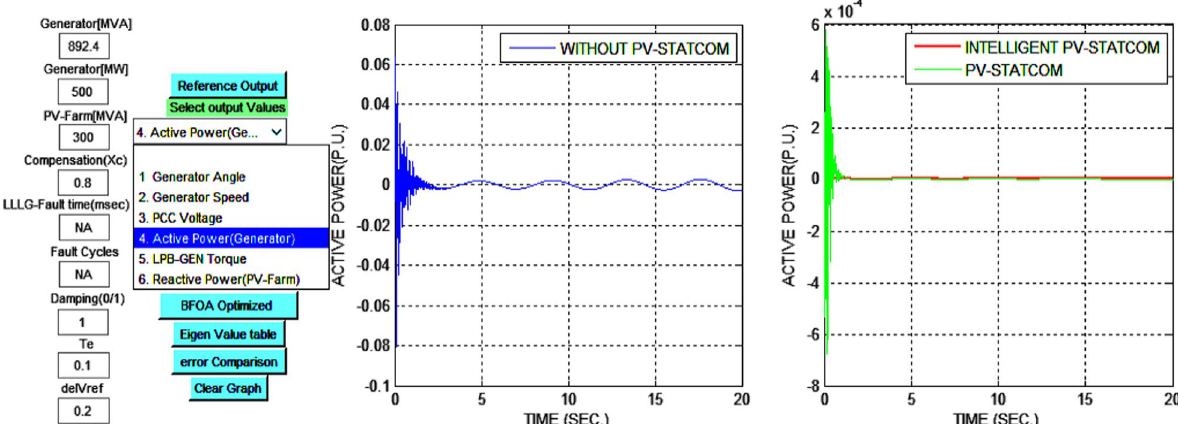
Fig. 19 Active power deviations (ΔP)